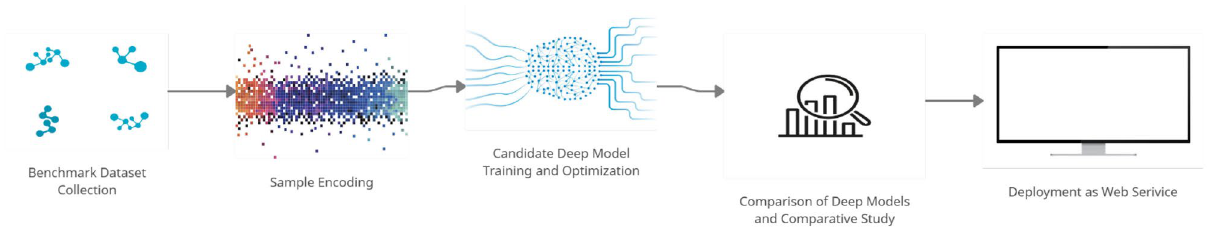
Figure 8. Proposed approach for Carboxyglutate(CarboxE) sites